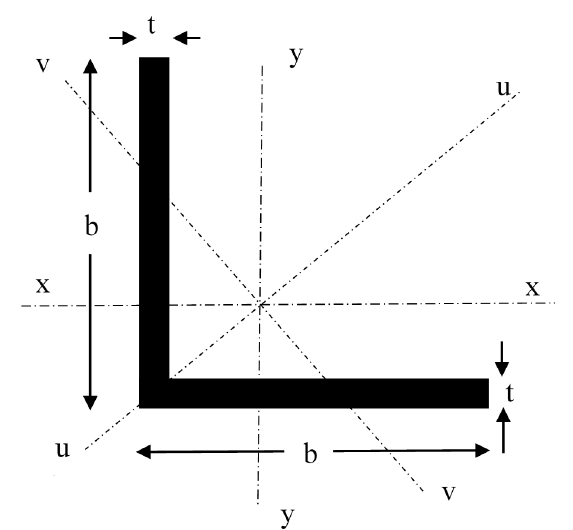
Figure 2. Geometry of angle section .